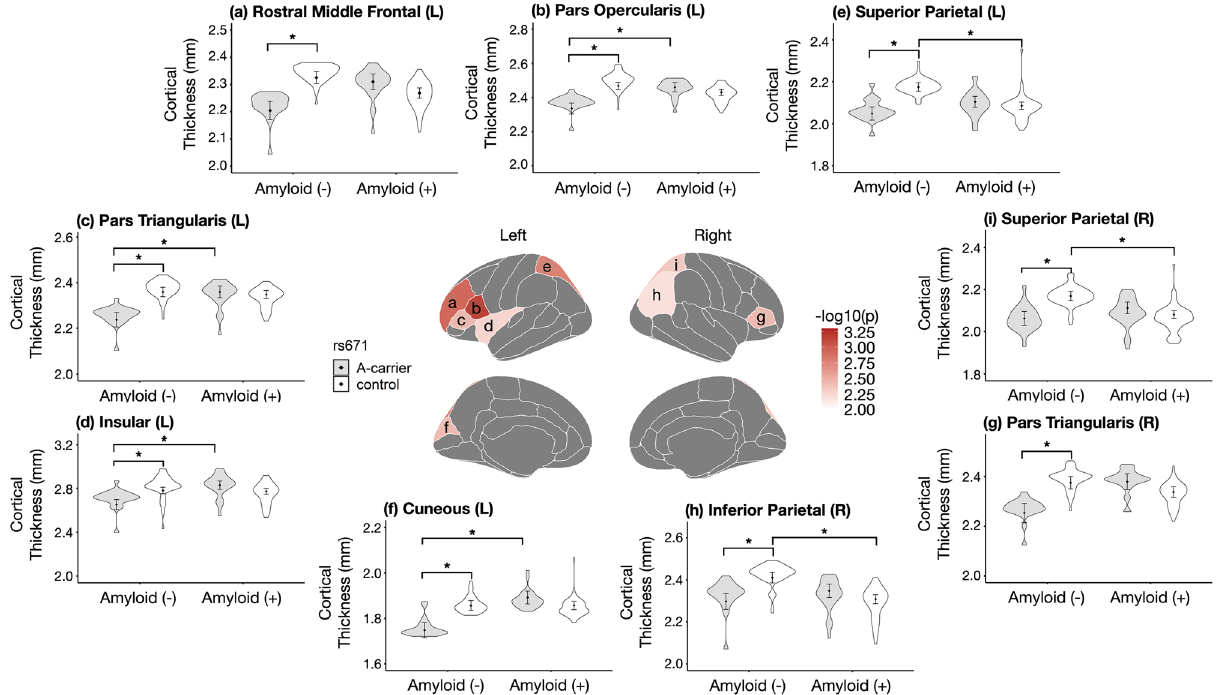
Figure 1. The results of the regression analyses of the interaction effect of amyloid deposition and rs671 polymorphism on brain cortical thickness using the Desikan–Killiany atlas and violin plot. After correction at FDR < 0.05, nine regions were observed, with six and three in the left and right hemispheres, respectively (Lt. cuneus, Lt. pars opercularis, Lt. pars triangularis, Lt. rostral middle frontal, Lt. superior parietal, Lt. insula, Rt. Inferior parietal, Rt. pars triangularis, Rt. superior parietal). The nine regions in the brain maps were color- coded using scales of -log10 (uncorrected p) from the multiple regression analysis. The violin plot was made with the estimated values obtained from regression analysis, and Lsmeans with standard errors were marked with error bars. Brain maps and bar plots was visualized using R-packages ggseg (https:// github. com/ ggseg/ ggseg) 41 and ggplot2 42